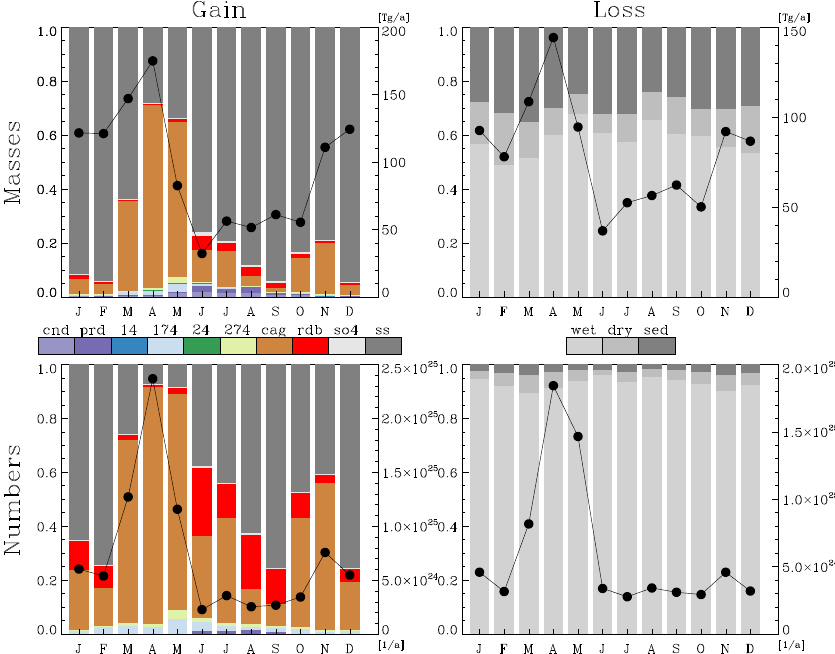
Figure 23. Seasonal cycle of regional tendencies of the hydrophilic coarse mode over East Asia (see Fig. 1). The colored bars show fractional tendencies (left axis) for the processes defined in Table 2. The solid line (right axis) shows the total tendency.